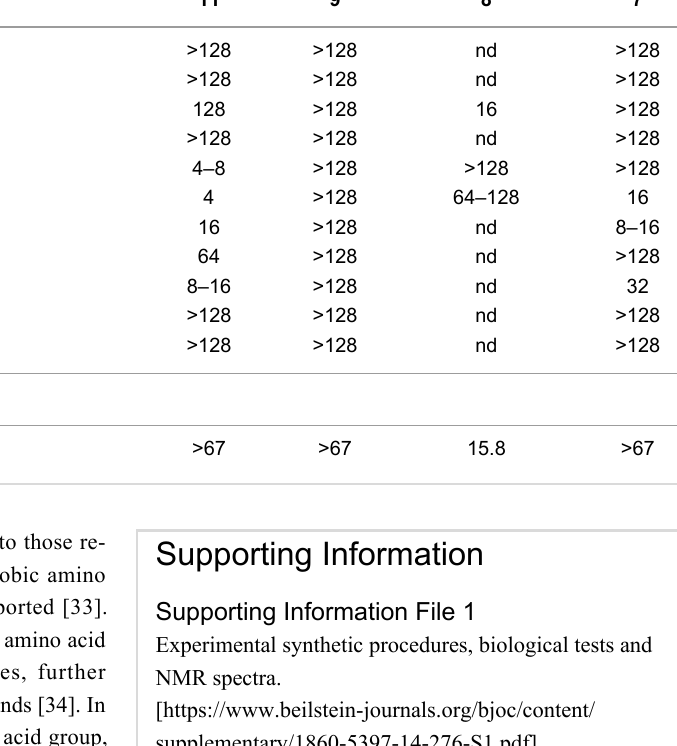
Table 3: Antimicrobial activity (minimum inhibitory concentration, MIC, in µg/mL) and cytotoxicity (minimum inhibitory concentration, MIC, in µg/mL) of selected NAVME, NABME and NAGME derivatives. Minimal inhibitory concentration and IC 50 values for cytotoxicity in μ g/mL.